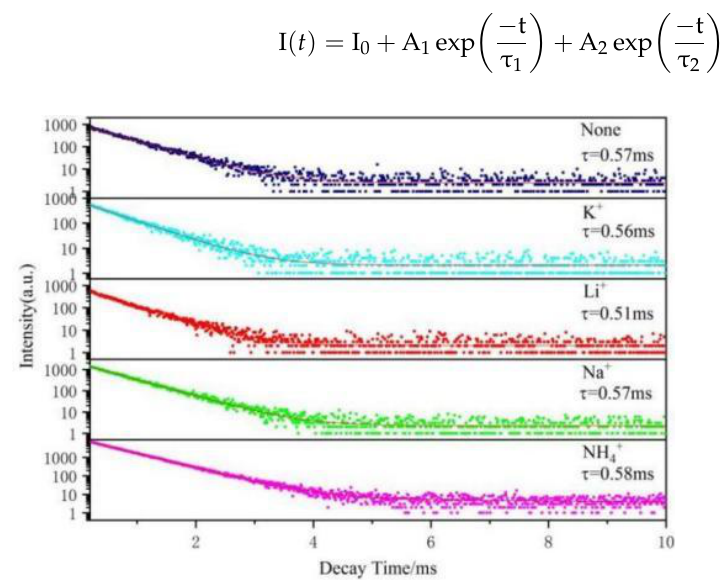
Figure 12. Lifetime decay curve of SrMo 0.5 W 0.5 O 4 :0.01Eu 3+ , A (A = Li + , Na + , K + , NH 4+ ). In the formula, I( t ) denotes the emission intensity at time t, I 0 represents the initial emission intensity, A 1 and A 2 are the pre-exponential factors of each decay component, and τ 1 and τ 2 are the decay times of each component. The average emission decay time ( τ ave ) can be calculated using the below